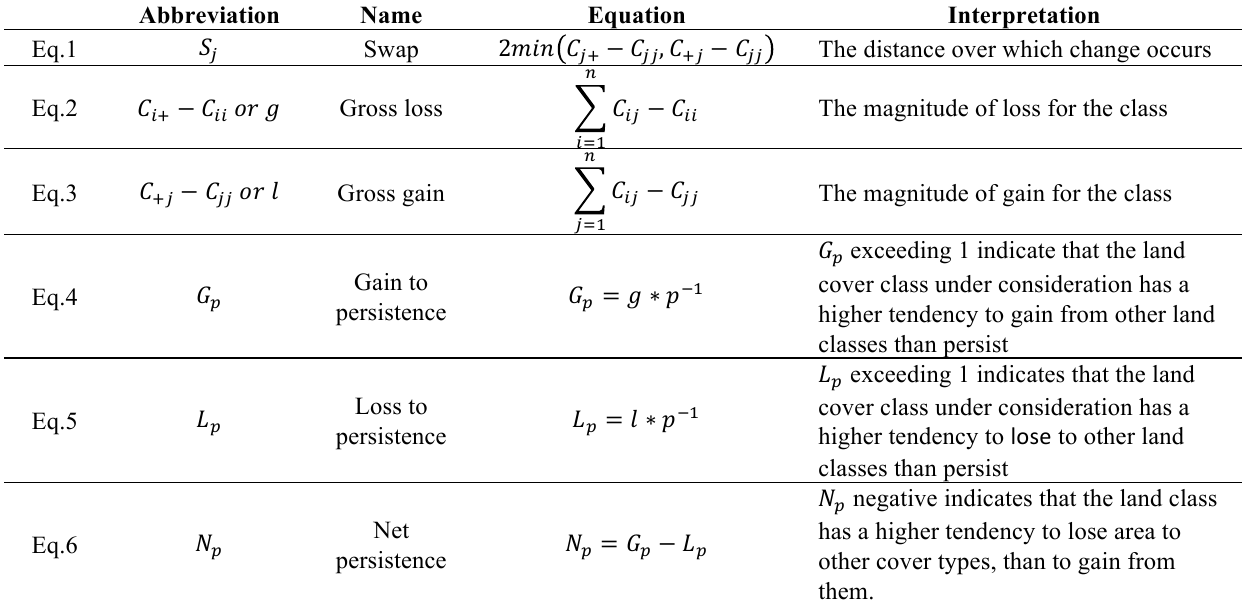
Table 2. Transition and vulnerability